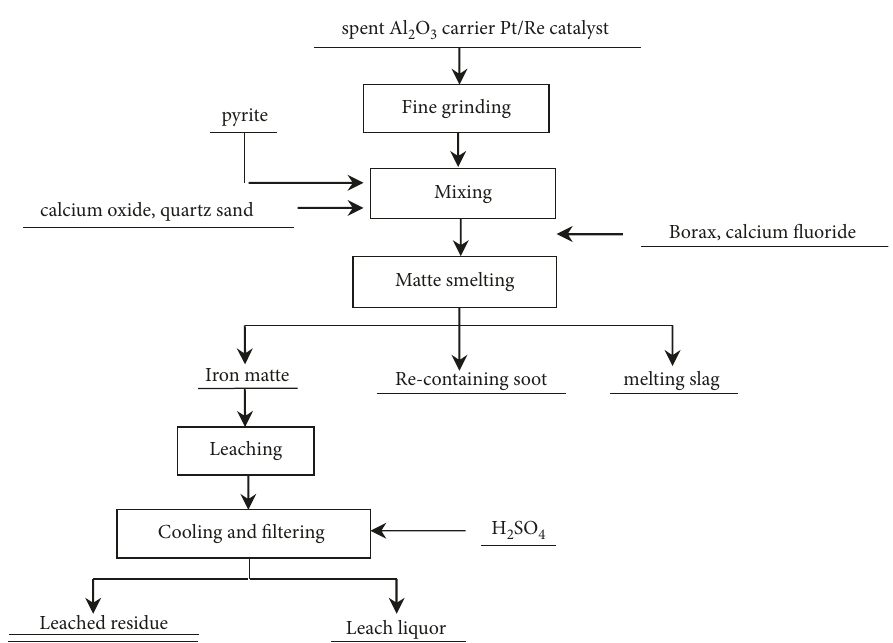
Figure 3: The process for the recovery of platinum from spent Al